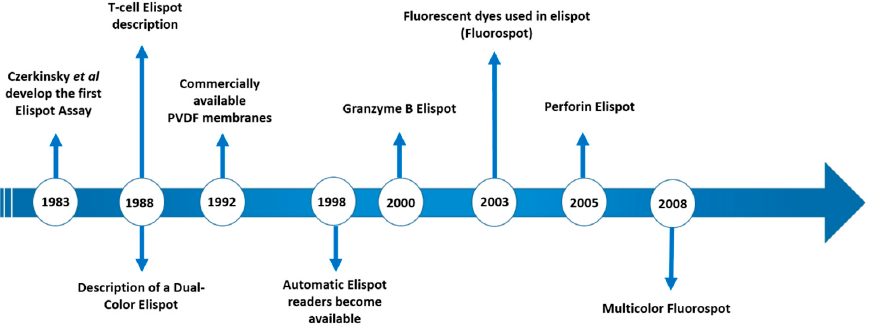
Figure 1. Timeline of the main Elispot advances over the past 3 decades.